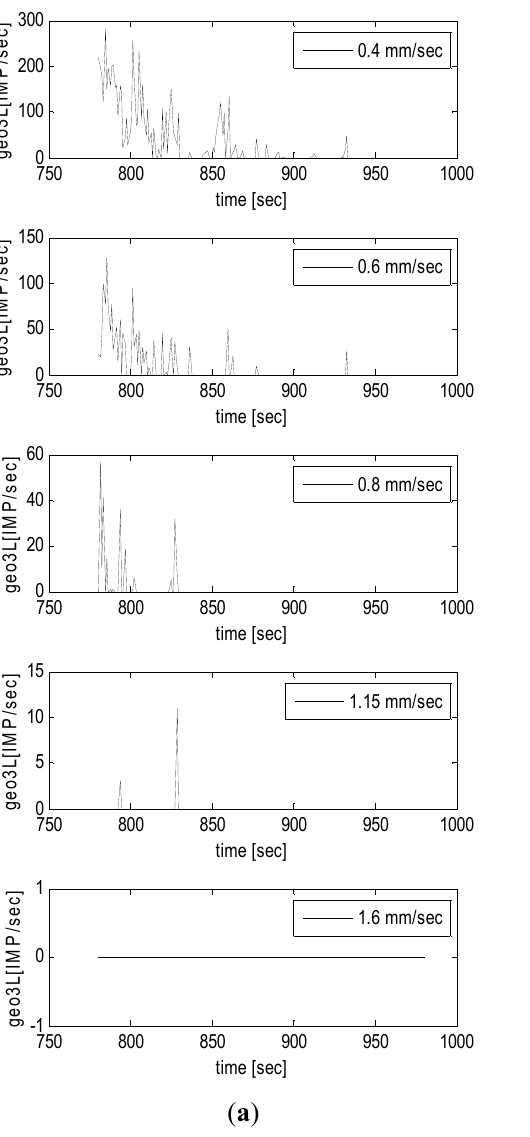
Figure 9. IS time series corresponding to different thresholds of ground velocity (from top to bottom: 0.4 mm/s, 0.6mm/s, 0.8 mm/s, 1.15 mm/s, 1.6 mm/s). ( a ) Dorfbach event (4 June 2011) and ( b ) Illgraben event (27 July